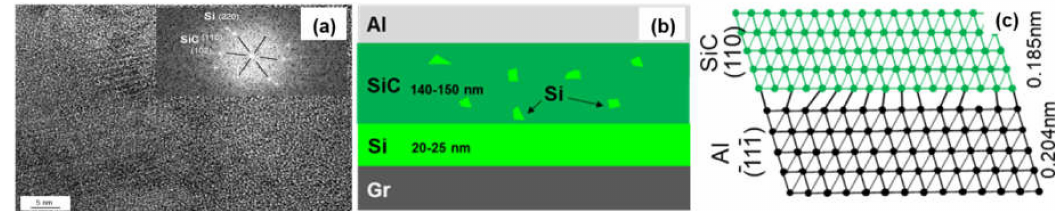
Figure 8. ( a ) HRTEM image of the SiC/Al interface; ( b ) Schematic drawing of interfacial structure of the Graphite/Al (Si) composites; ( c ) Schematic diagram of the SiC/Al interfacial structure.